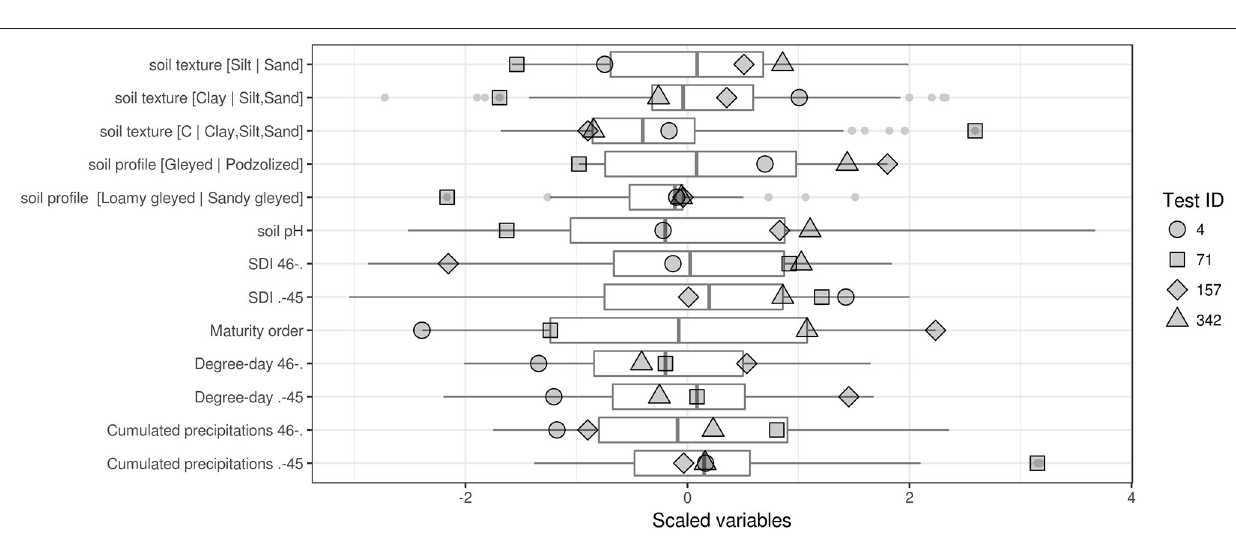
the symbols represent blocks. The curves are drawn using the trial-level random effect (level 1). The model was fitted across the whole data set: trials are specific application of the